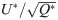
Map of the ratio U*/Q*, as function of normalized height, H*.The empty and filled symbols correspond to straight and curled traces, respectively. Each symbol represents experiments for different fluids, see Table 1. The black asterisk shows (HPollock*,(U*/Q*)Pollock), considering the measurements shown in Fig 5, the physical properties of black paint B1 (from Table 1) and the calculation of Qstick* (from Eq 11). The solid-line rectangle shows a region considering one standard deviation (plus and minus) around mean values of height and speed. The dashed and dashed-dotted rectangles show the regions that correspond to fluids with twice and half the value of the viscosity of fluid B1, respectively. The thick dashed line shows the prediction from Eq 19.